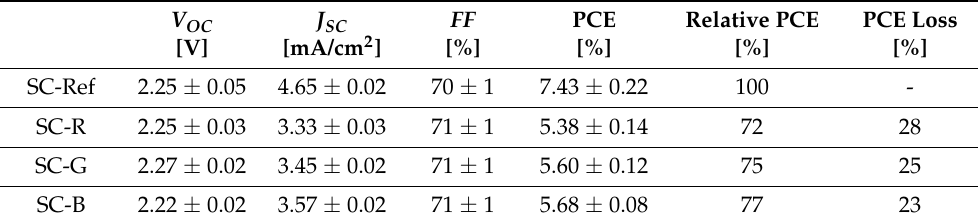
Table 1. Performances of the four modules investigated in this study. V OC